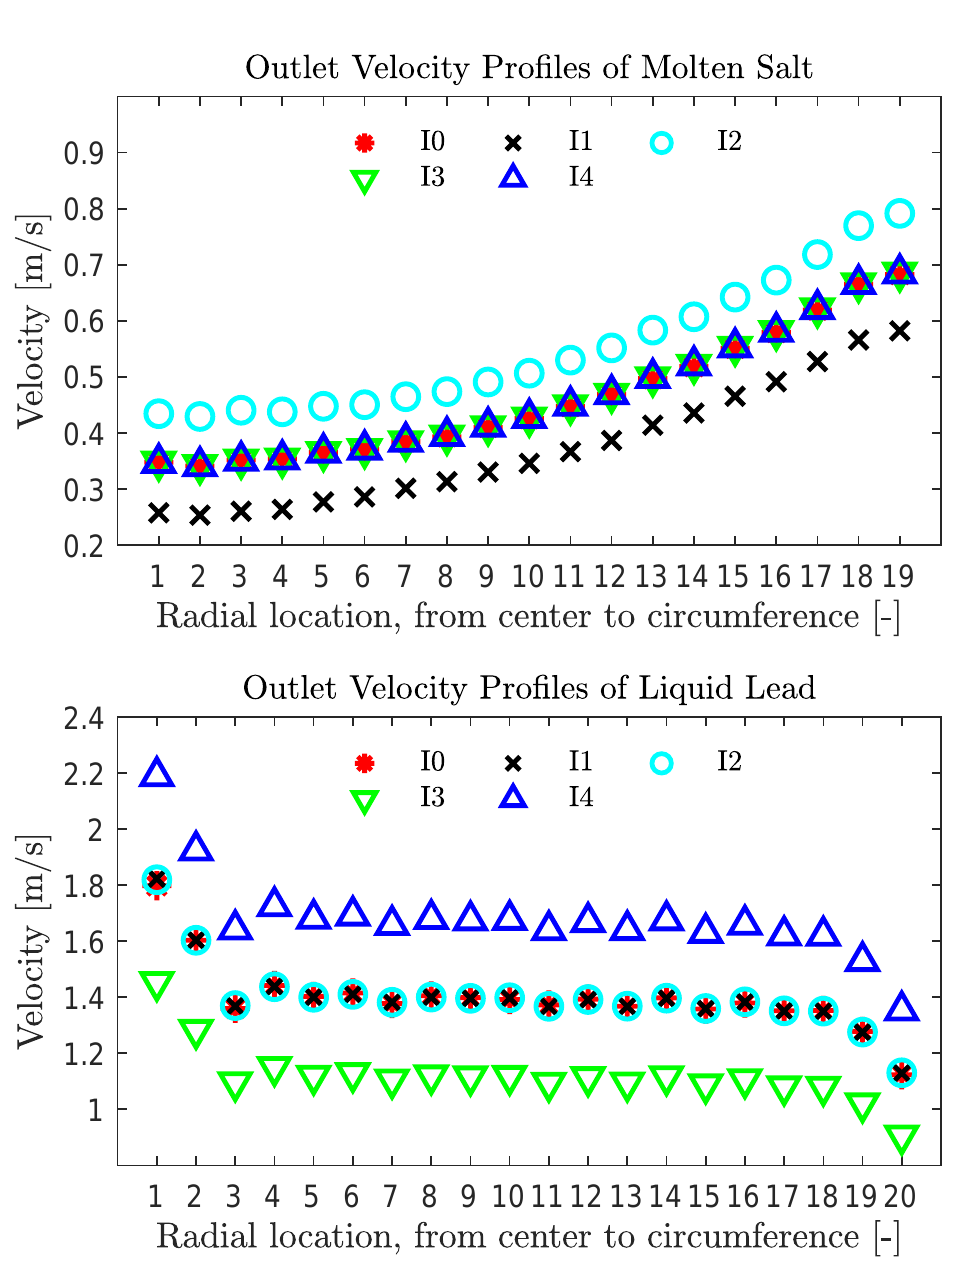
Figure 15. Outlet velocity distribution at various inlet scenarios: top, velocity profiles of molten salt; bottom, velocity profiles of liquid